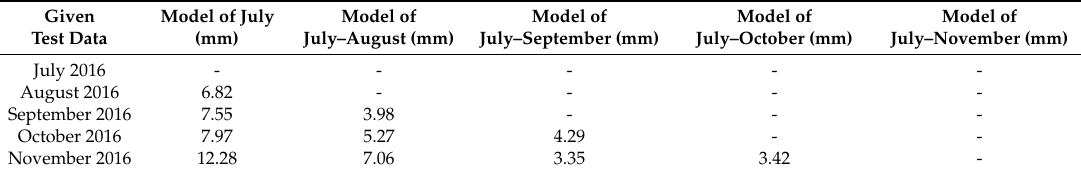
Table 4. Root-mean-square error (RMSE) values with respect to different sets of test